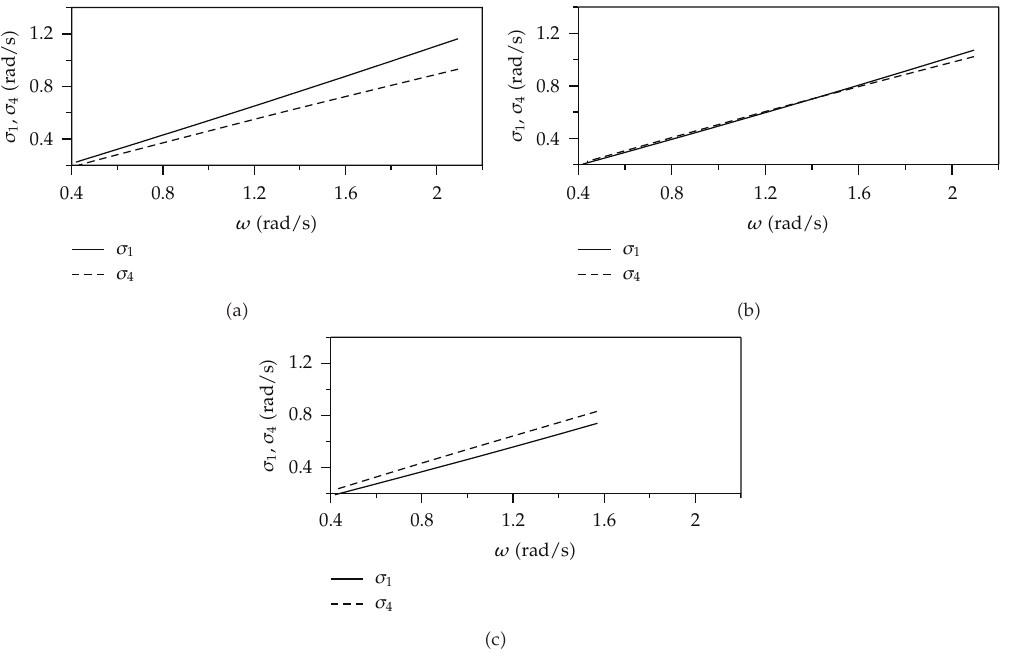
Figure 6: Two internal wave frequencies as functions of surface wave frequency ω , H (cid:8) 4m, h (cid:8) 0 . 1m (cid:4) a (cid:5) γ (cid:4) (cid:8) γ (cid:4)(cid:4) (cid:8) 0 . 83, (cid:4) b (cid:5) γ (cid:4) (cid:8) 0 . 83, γ (cid:4)(cid:4) (cid:8) 0 . 77, and (cid:4) c (cid:5) γ (cid:4) (cid:8) 0 . 83, γ (cid:4)(cid:4) (cid:8) 0 .